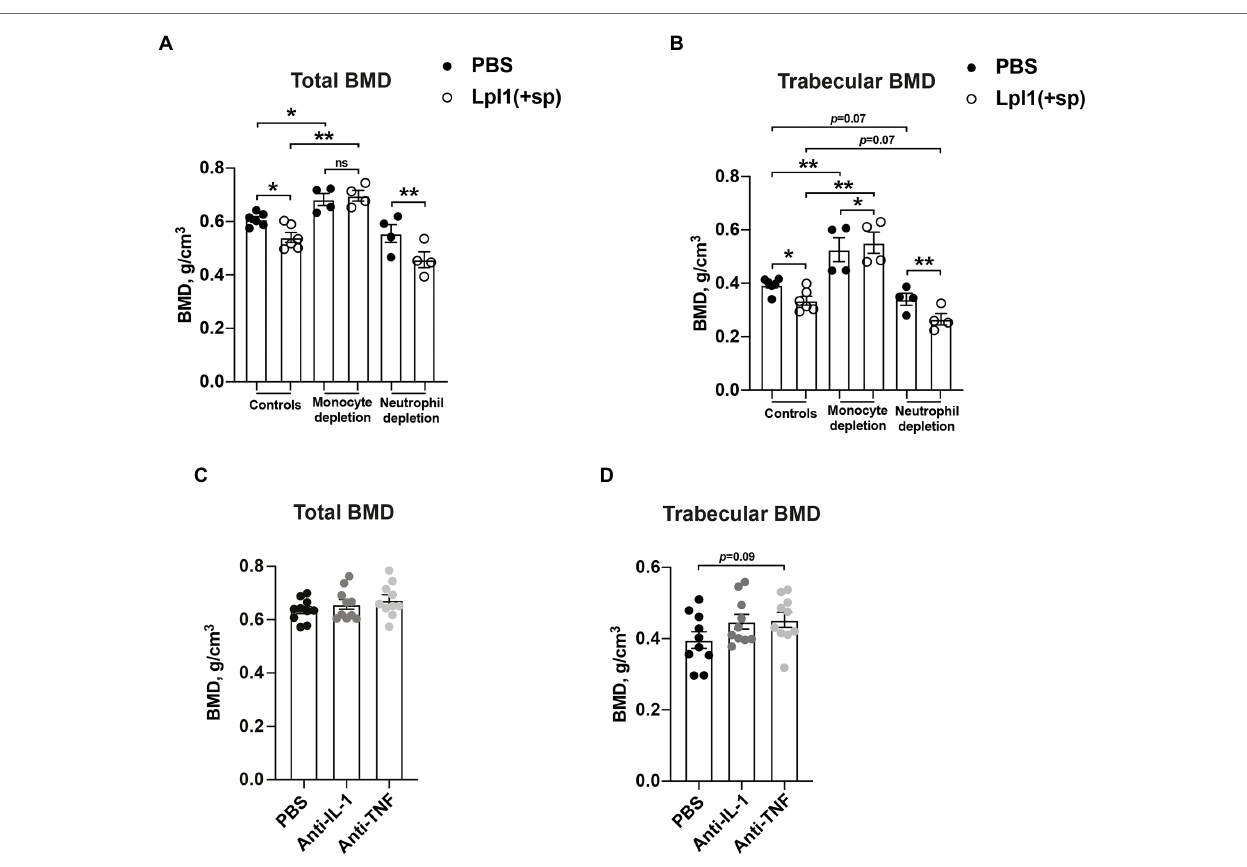
FIGURE 4 | Monocytes, and not neutrophiles, are the culprits behind Staphylococcus aureus Lpp-induced bone destruction. (A) Total- and (B) trabecular BMD (g/ cm 3 ) of femoral mouse knee joints 7 days post intra-articular (i.a.) injection with 20 μ l of purified S. aureus lipoprotein Lpl1(+sp; 10 μ g/knee) or phosphate-buffered saline (PBS), measured in NMRI control mice ( n = 6 knee joints/group) or NMRI mice depleted of either monocytes/macrophages using clodronate liposomes ( n = 4 knee joints/group) or neutrophils using anti-Ly6G antibodies ( n = 4 knee joints/group). (C) Total- and (D) trabecular BMD of femoral mouse knee joints 10 days post i.a. injection with 20 μ l of purified Lpl1(+sp; 10 μ g/knee), measured in NMRI mice treated with either anakinra, an interleukin 1 receptor antagonist (anti-IL-1) or etanercept, and a tumor necrosis factor inhibitor (anti-TNF) or PBS as control ( n = 10 knee joints/group). Statistical evaluations were performed using the Paired t test between PBS and Lpl1(+sp) injected mice originating from the same host (A,B) or Mann–Whitney U test between PBS and Lpl1(+sp) injected mice of different treatment groups (A,B) or between PBS, anti-IL-1, or anti-TNF injected mice (C,D) , with the data presented as a scatterplot with data expressed as the mean ± standard error of the mean (* p < 0.05 and ** p < 0.01, ns = not